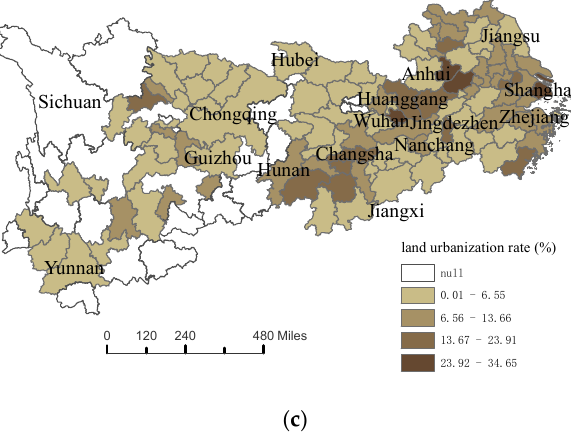
Figure 4. Land urbanization of YREB: ( a ): 2001; ( b ): 2011; ( c ): 2019.